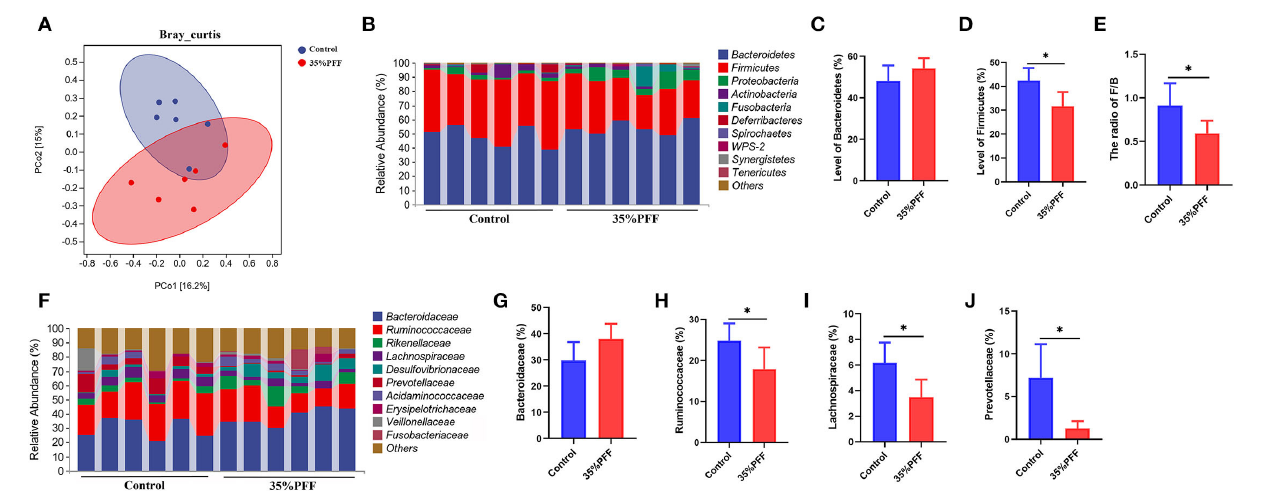
FIGURE 2 | Effects of PFF on gut microbiota in Shaoxing ducks. (A) PcoA score plot. (B) Phylum-level distribution of fecal microbiota. (C,D) Relative abundance of the phyla Firmicutes and Bacteroidetes. (E) The ratio of Firmicutes/Bacteroidetes (F/B) levels. (F) Family-level distribution of fecal microbiota. (G–J) The relative abundance of Bacteroidaceae, Ruminococcaceae, Lachnospiraceae, and Prevotellaceae. * p <